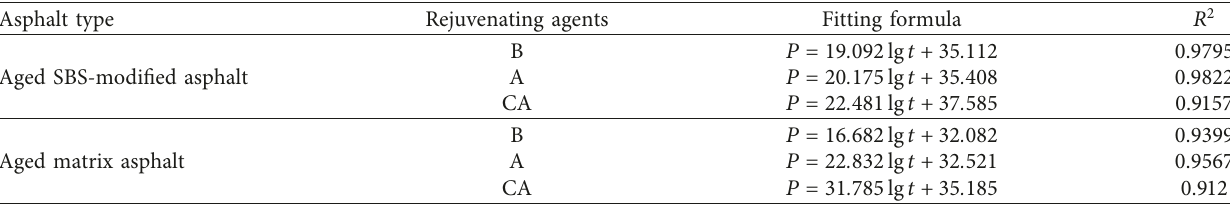
Figure 10: Penetration curves of aged asphalt after adding rejuvenating agents at a certain holding time: (a) recycled matrix asphalt; (b) recycled SBS-modified asphalt. Table 4: Change curves of penetration of two regenerated asphalt